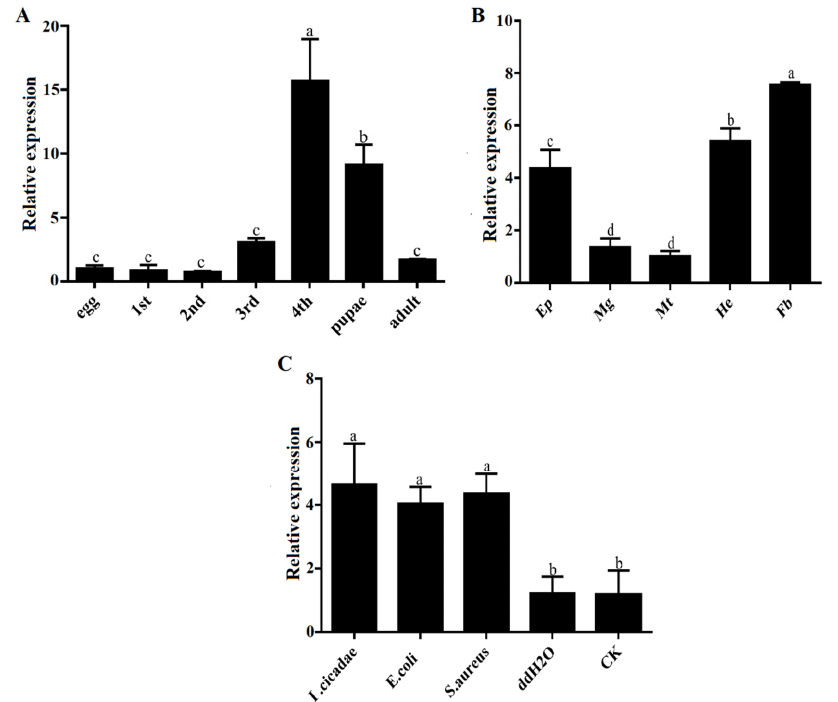
Figure 3. Relative expression levels of PxTrf . ( A ) Different developmental stages. Total RNA was extracted from the whole body of P. xylostella . ( B ) Different tissues of the fourth instar larvae. Ep: epidermis; Mg: midguts; Mt: malpighian tubules; He: hemocytes; Fb: fat bodies. ( C ) Different microbial challenges of the fourth instar larvae. Data are presented as the mean of three replicates ± standard error. Different lowercase letters indicate significant variations in transcription among di ff erent samples ( p < 0.05). Table 2. Identification of PxTrf protein in P.